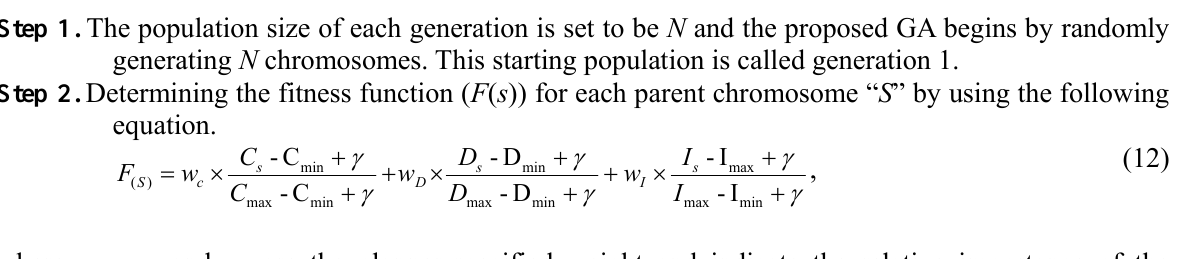
Fig. 1. Pseudo code of the simple genetic